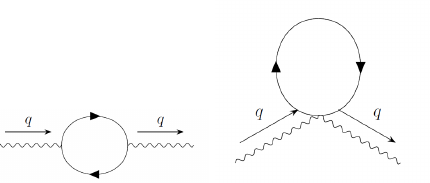
Figure 2. Vacuum polarization one loop graphs.